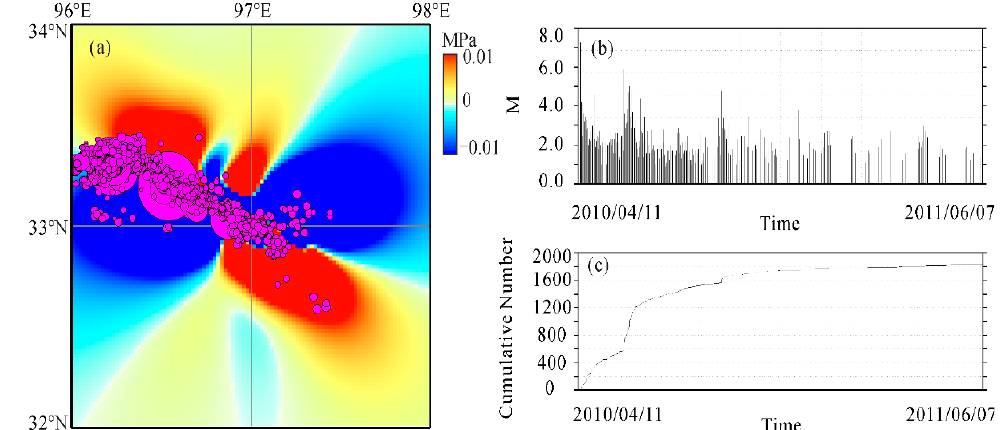
Figure 4. ( a ) Distribution of coseismic Coulomb failure stress changes caused by the 2010 Ms 7.1 Yushu earthquake at the depth of the mainshock and aftershocks (Zhu et al. [73]). ( b ) Temporal distribution of aftershock magnitudes. ( c ) Cumulative number of aftershocks over time.